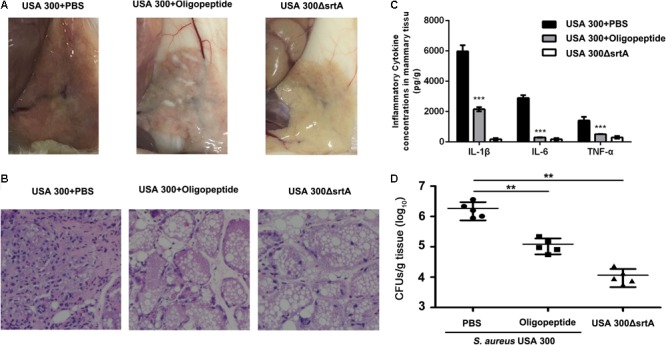
Oligopeptide provides protection against S. aureus mastitis in a mouse model. Lactating BALB/c mice were infected by injecting the canal glands with 5 × 107 CFU bacterial cells and treatment with the oligopeptide or PBS at the time of infection. Gross pathological changes (A) and histopathological analysis (B) of the mammary gland tissues at 48 h post-infection (n = 10). Significant alleviation of the pathological abnormalities was observed in the infected mice that received 50 mg/kg oligopeptide compared with the control mice treated with PBS. (C) Oligopeptide reduces the inflammatory response in infected mice. The levels of cytokines, including IL-1β, IL-6, and TNF-α, in the mammary gland tissues of infected mice were evaluated by ELISA (n = 10) (∗p < 0.05, ∗∗∗p < 0.001). (D) The effect of the oligopeptide on the bacterial burden in infected mice. Mammary gland tissues were collected, homogenized, and plated on TSB agar plates for assessment of the bacterial burden (n = 5) (∗p < 0.05, ∗∗p < 0.01). Results are reported as mean ± SEM.